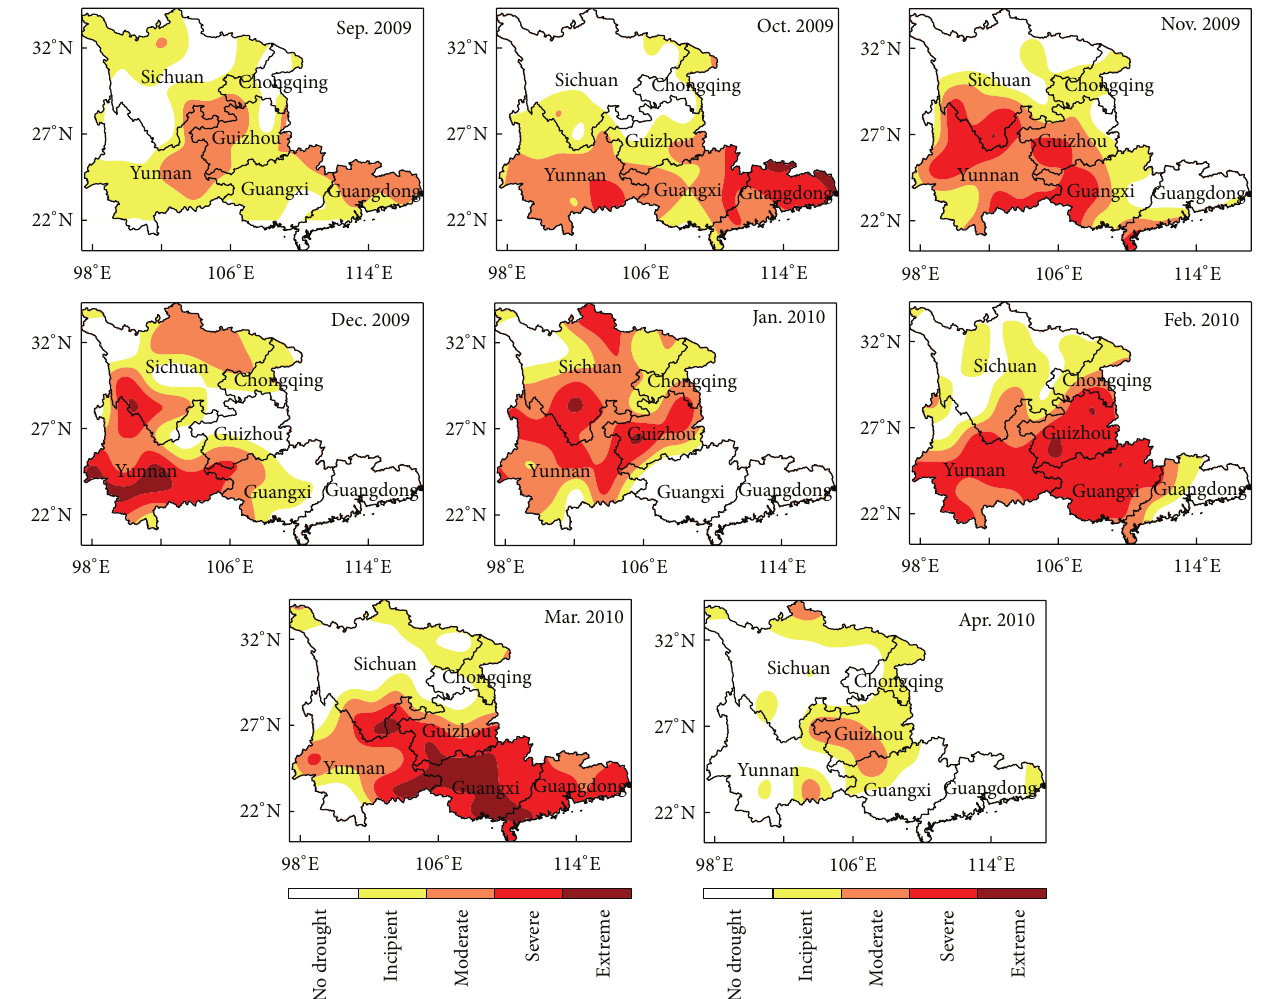
Figure 2: Distribution of droughts of varying severity as judged by the 𝐾 index (Sept. 2009 to Apr. 2010).